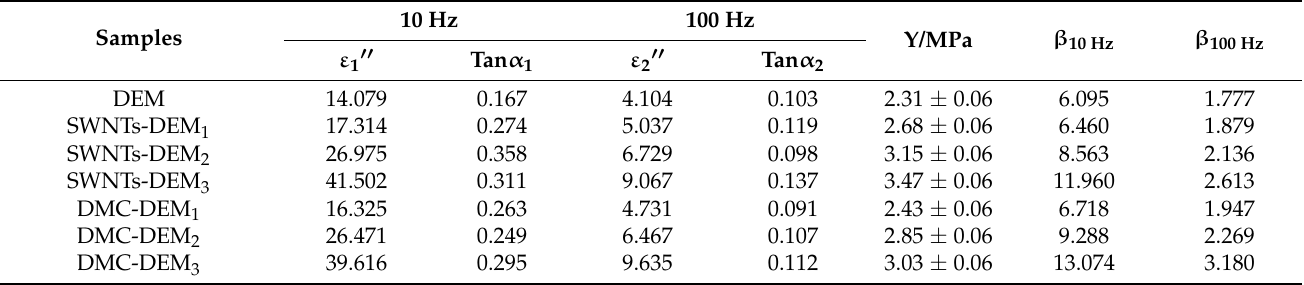
Table 6. Dielectric properties of polyurethane fiber membrane.